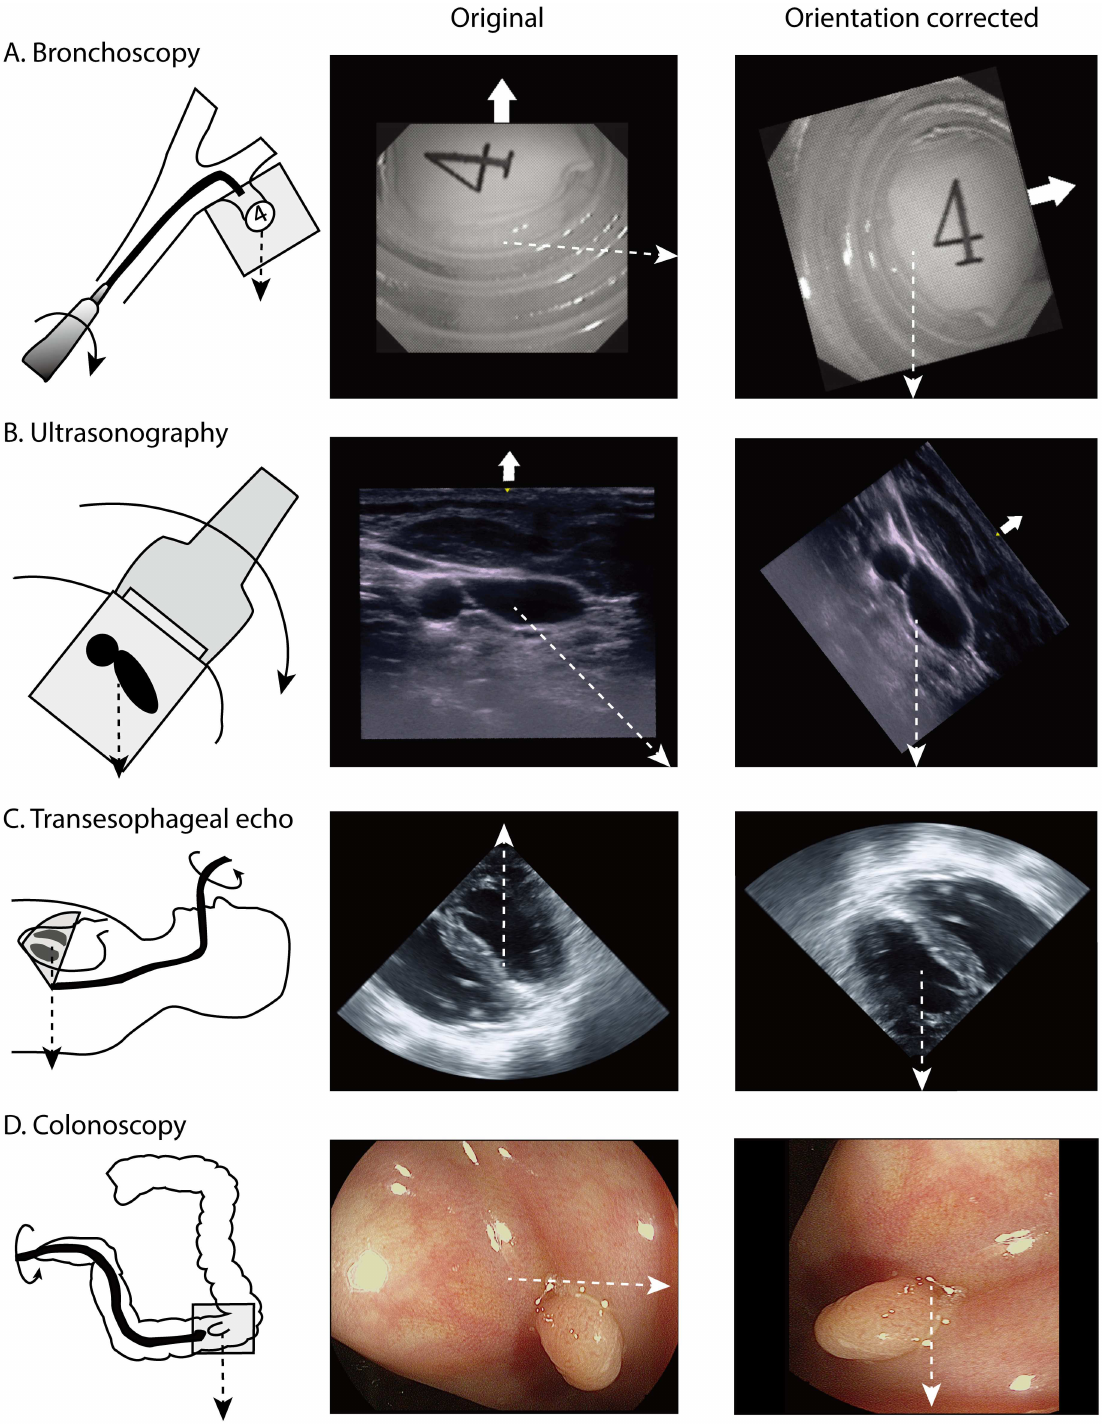
Fig 5. Images before and after orientation correction in various clinical situations. A. With flexible endoscopy, changing the directionrequiresaxial rotation of the endoscope. The gravitational distortion due to the rotation can be corrected by the orientation correction system. The procedure is also easier becausethe directionof the endoscopetip coincideswith the spatial orientation of the endoscopist. This image was captured using the orientationcorrection system used in this study. B. With ultrasound-guidedcatheter insertion, the image orientationcorrection system can help to match the spatialorientationof the image and the operator. This image was capturedusing the orientation correction system used in this study. C. With